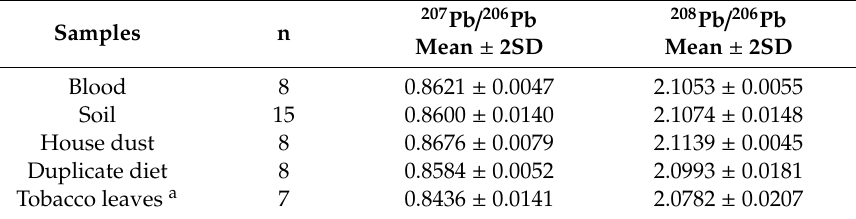
Table 4. Isotope ratios of blood Pb and bioaccessible Pb in environment samples.